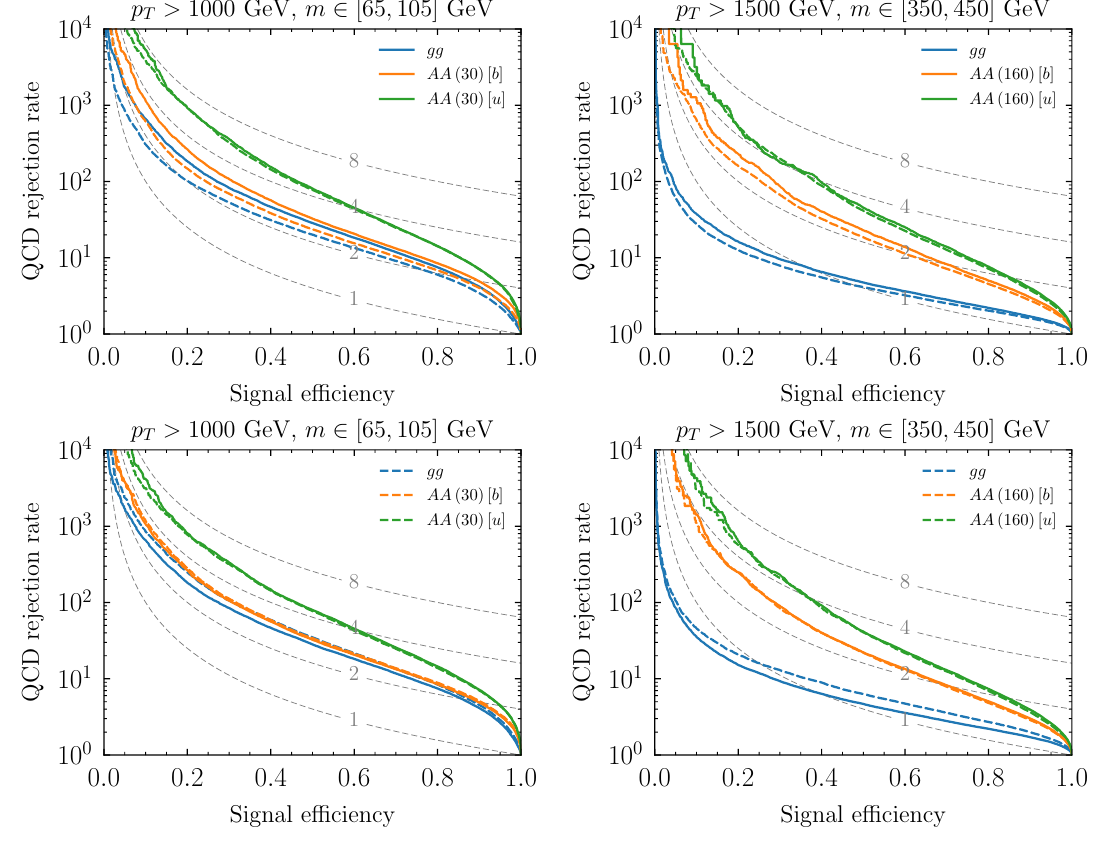
Figure 8 . Top: e(cid:11)ect of b quarks on training, on various test signals. Solid lines correspond to standard choice of MI data for training, and dashed lines correspond to MI data without b quarks in the (cid:12)nal state for training. Bottom: e(cid:11)ect of gluons on training, on various test signals. Solid lines correspond to standard choice of MI data for training while dashed lines correspond to MI data as well as gluons in the (cid:12)nal state for